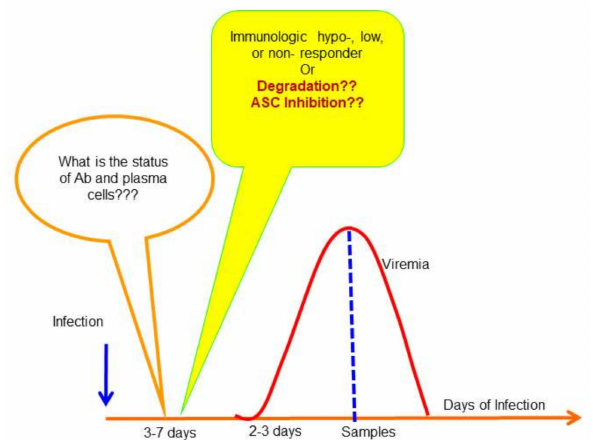
Figure 3. Status of antibody secretion cells and antibodies prior to onset of fever in dengue patients. The diagram described the course of DENV infection in patients. There is a gap about 3–7 days prior to fever onset in a ff ected people. The status of antibody secretion cells is unknown, and the levels of antibodies in those confirmed with previously DENV infected subjects also remain largely